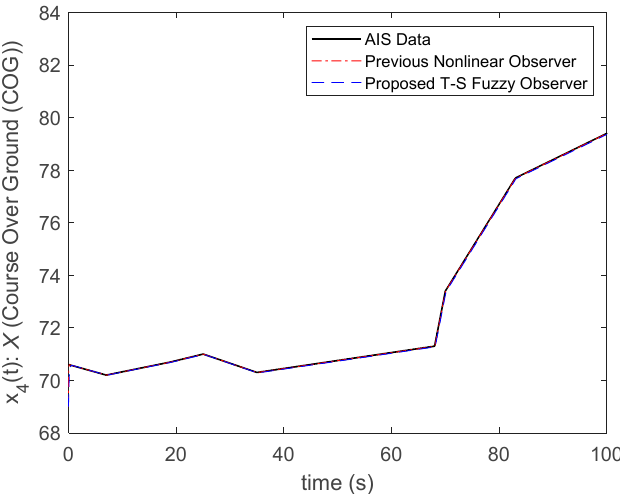
Figure 8. Comparison results of state ( )